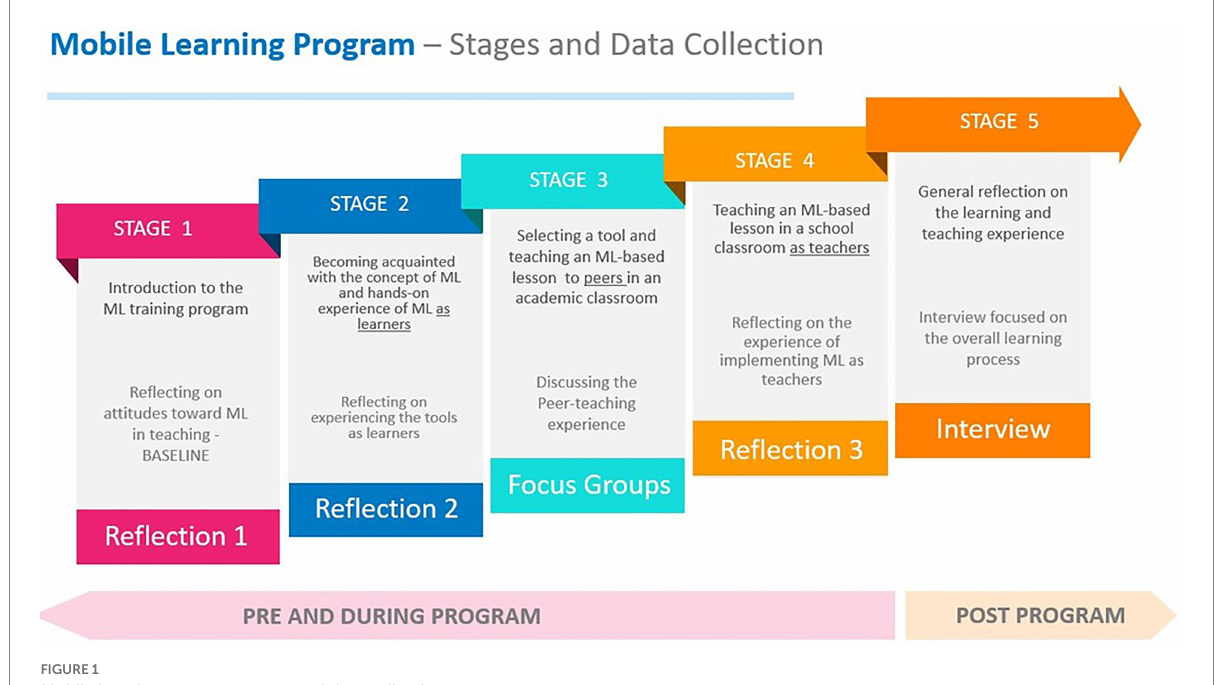
FIGURE 1 Mobile learning program-stages and data collection.